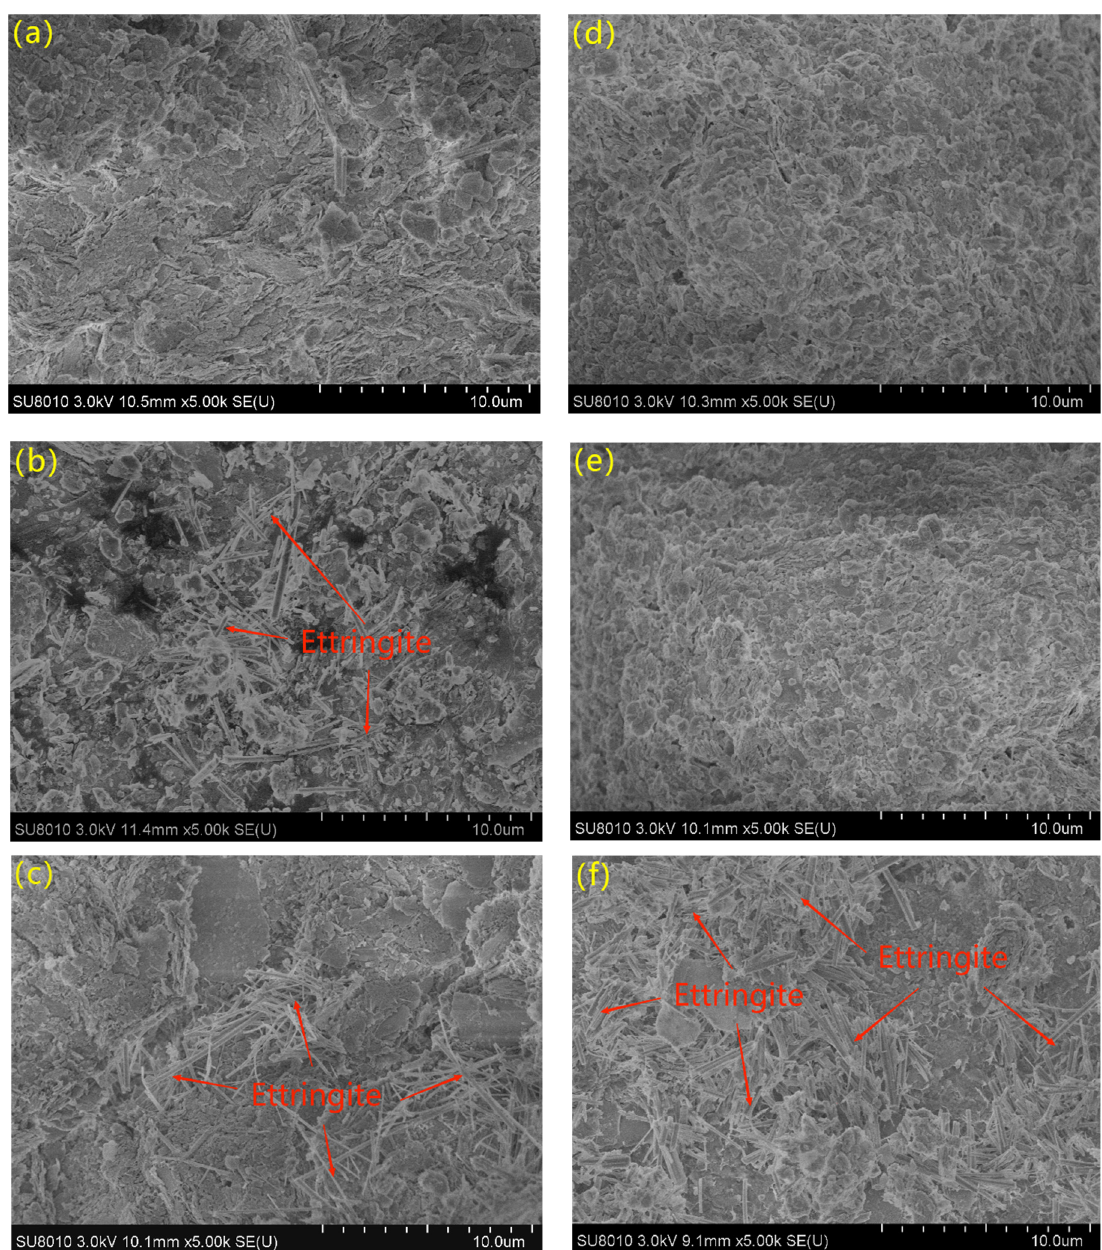
Figure 10. SEM photos of treated soils after soaking: Ca-sulfate-soil treated by ( a ) GGBS:MgO = 9:1; ( b ) GGBS:MgO = 6:4, ( c ) cement; Mg-sulfate-soil treated by ( d ) GGBS:MgO = 9:1; ( e ) GGBS:MgO = 6:4; ( f ) cement.